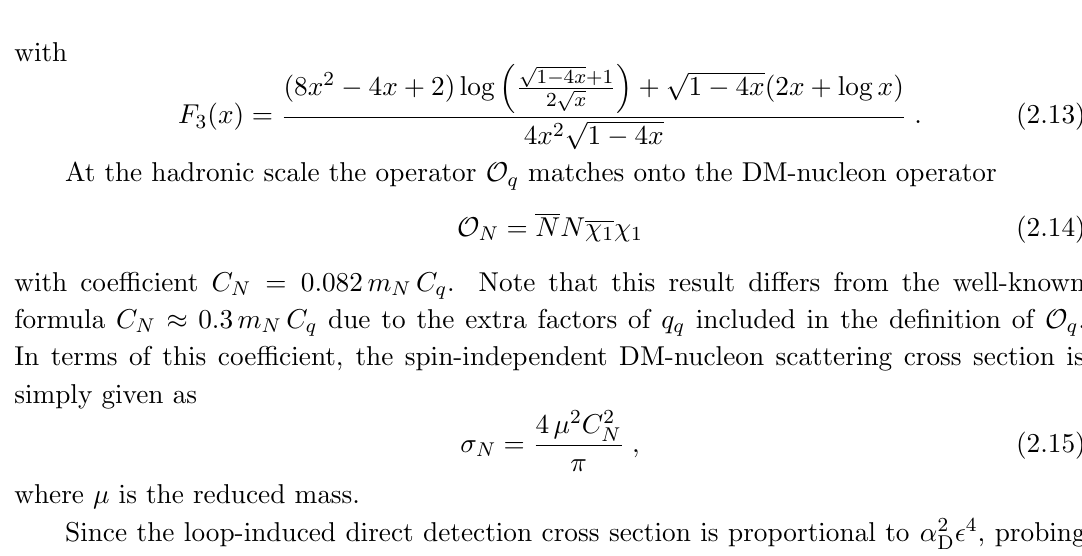
Figure 2 . The Feynman diagram depicting the photon and displaced fermion signature in the context of the inelastic DM